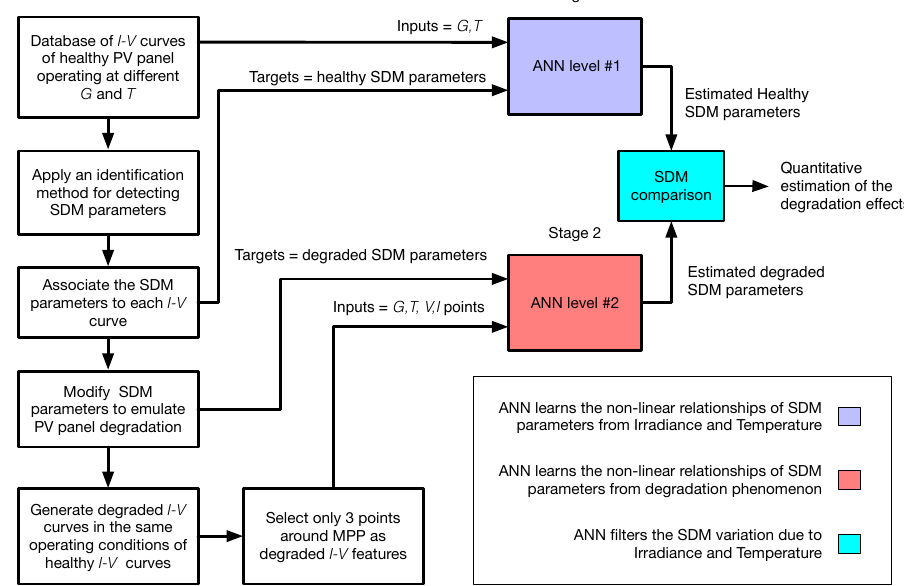
Figure 3. Flow chart for training the proposed ANN